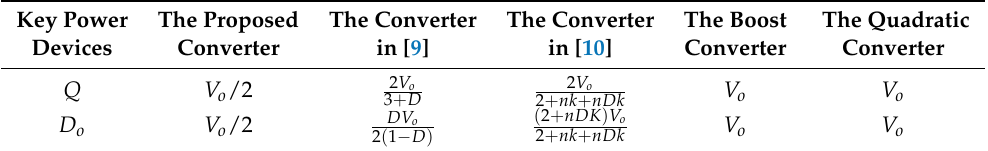
Table 1. The voltage stress comparison of key